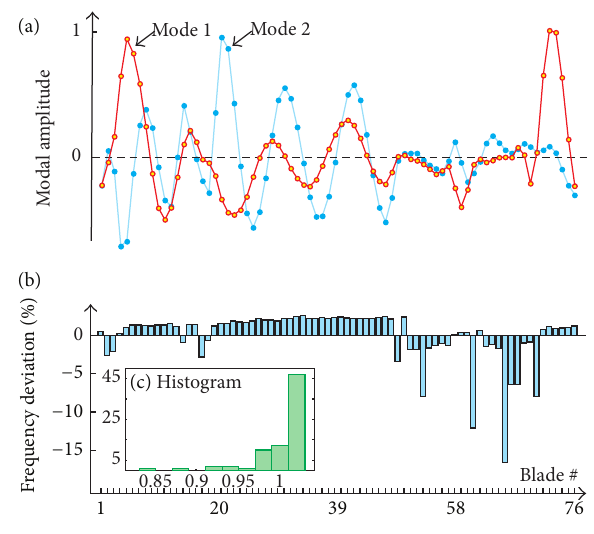
Figure 12: (a) Shapes of the two modes closer to 𝑛 = 7 diameters. (b) Distribution of the frequency deviation of the various blades (the frequencies are measured from impulse response tests); the blades in the vicinity of blade #65 have abnormally large deviations. (c) Histogram of the frequency